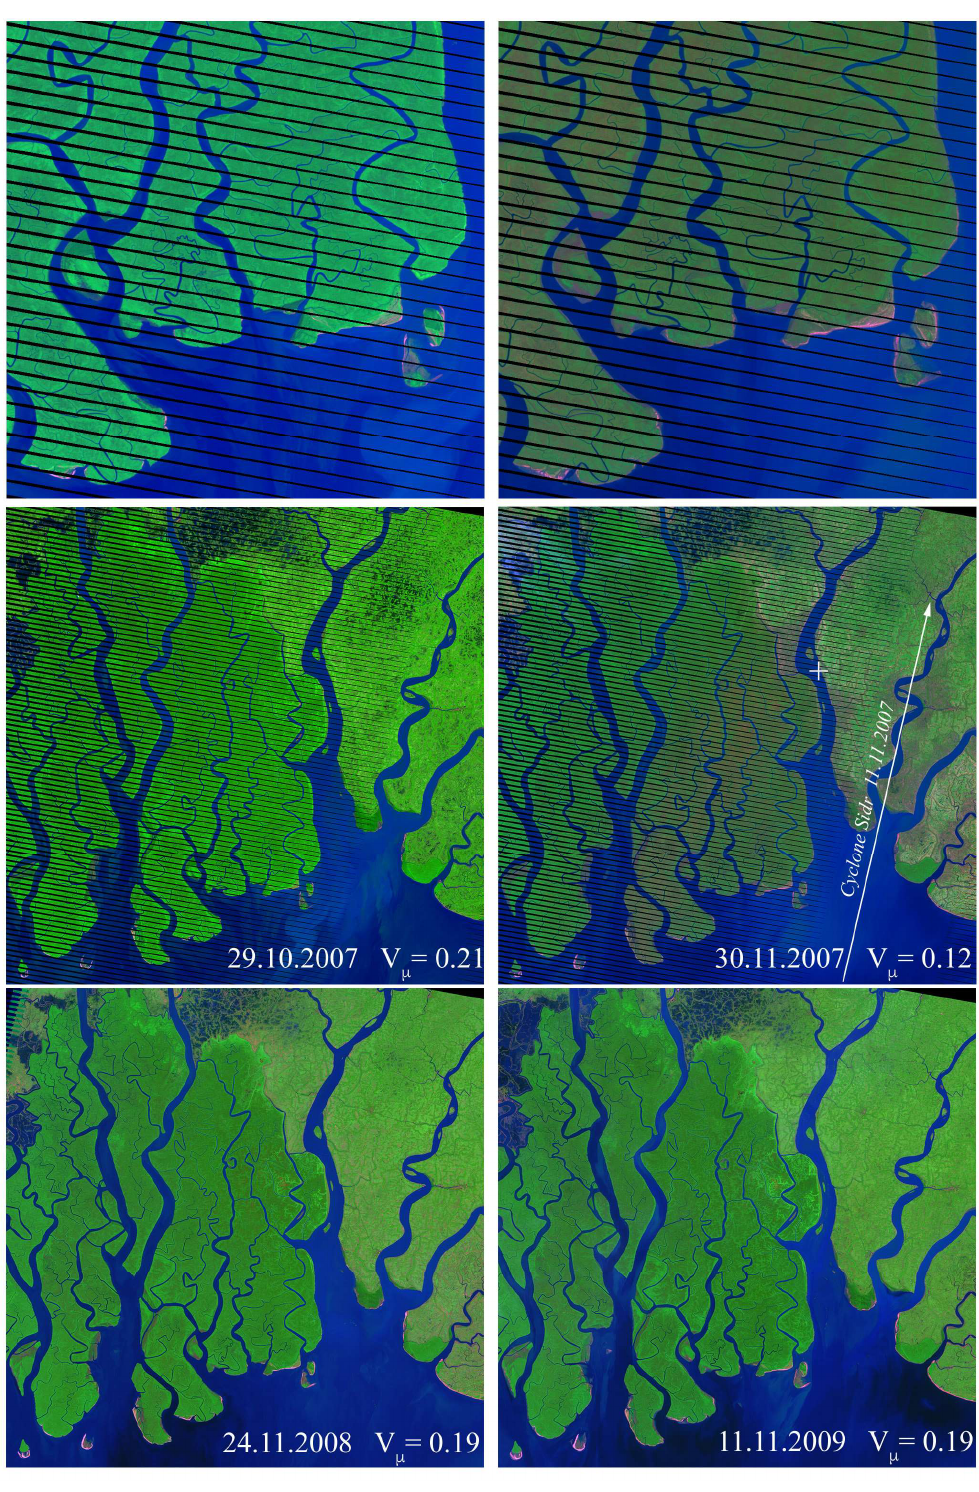
Figure 12. Impact and recovery from Cyclone Sidr on 11.11.2007. Mean vegetation fraction from forest south and west of 22.2°N 89.9°E (cross) drops 0.08 immediately after Sidr but recovers almost fully to its long-term mean of 0.20 (including shadow & water) by the following year. The area of mangrove defoliation (brown on 30.11.2007) is localized to a NNE-SSW swath immediately west of the cyclone track. Defoliation and erosion was most pronounced along south-facing shorelines (top) but measurable shoreline retreat was more